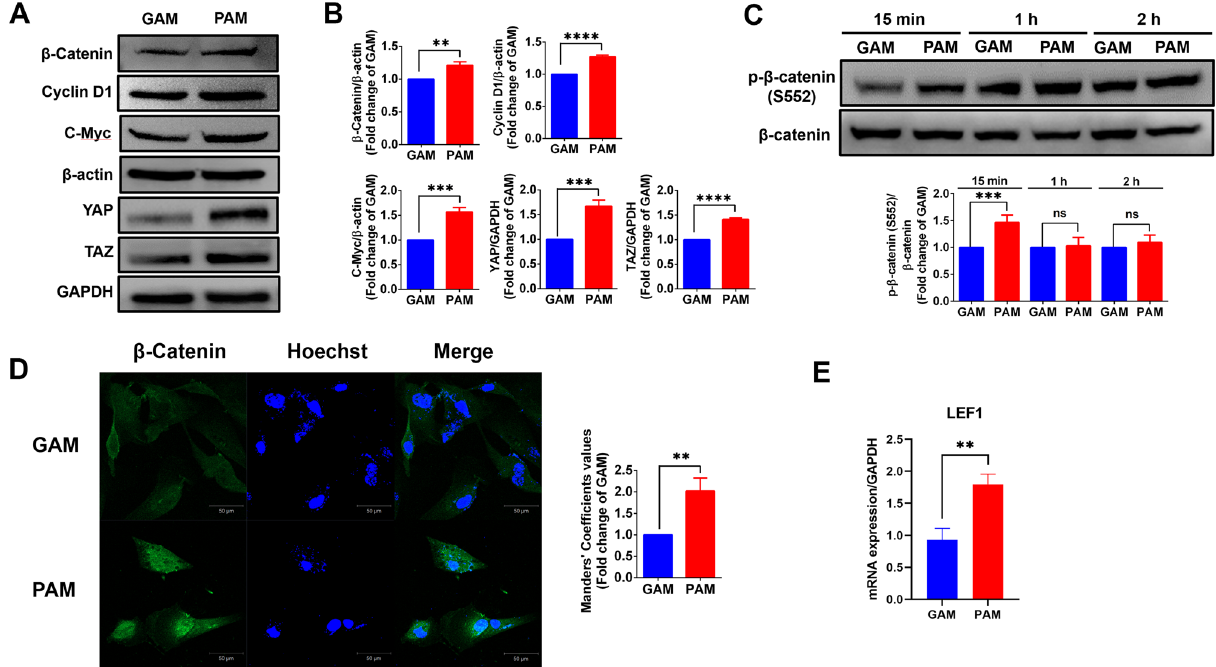
Figure 2. PAM upregulates protein expression of the β-catenin signaling pathway and YAP/TAZ and enhances β-catenin translocation in hDPCs. ( A ) Representative immunoblots and ( B ) Relative fold-change expressions of β-catenin, cyclin D1, c-Myc, YAP, and TAZ in PAM-treated hDPCs, after 18 h of incubation. ( C ) Representative immunoblots and relative fold-change expression of p-β-catenin (S552)/β-catenin level in PAM-treated hDPCs, compared to gas control, at 15 min, 1 h, and 2 h of incubation times. ( D ) Representative images of β-catenin immunofluorescence staining and quantitative nuclear β-catenin fluorescence intensity of GAM and PAM against hDPCs for 15 min incubation. The cells were observed under a confocal microscope with 20 × magnification. The scale bar indicates a 50 µm distance. ( E ) The mRNA expressions of LEF1 genes in PAM-treated hDPCs, after 18 h of incubation. All data are shown as the mean ± SD of experiments conducted in triplicate. Statistical significance; ** P < 0.01; *** P < 0.001, and **** P < 0.0001. ns indicates not significant ( P >